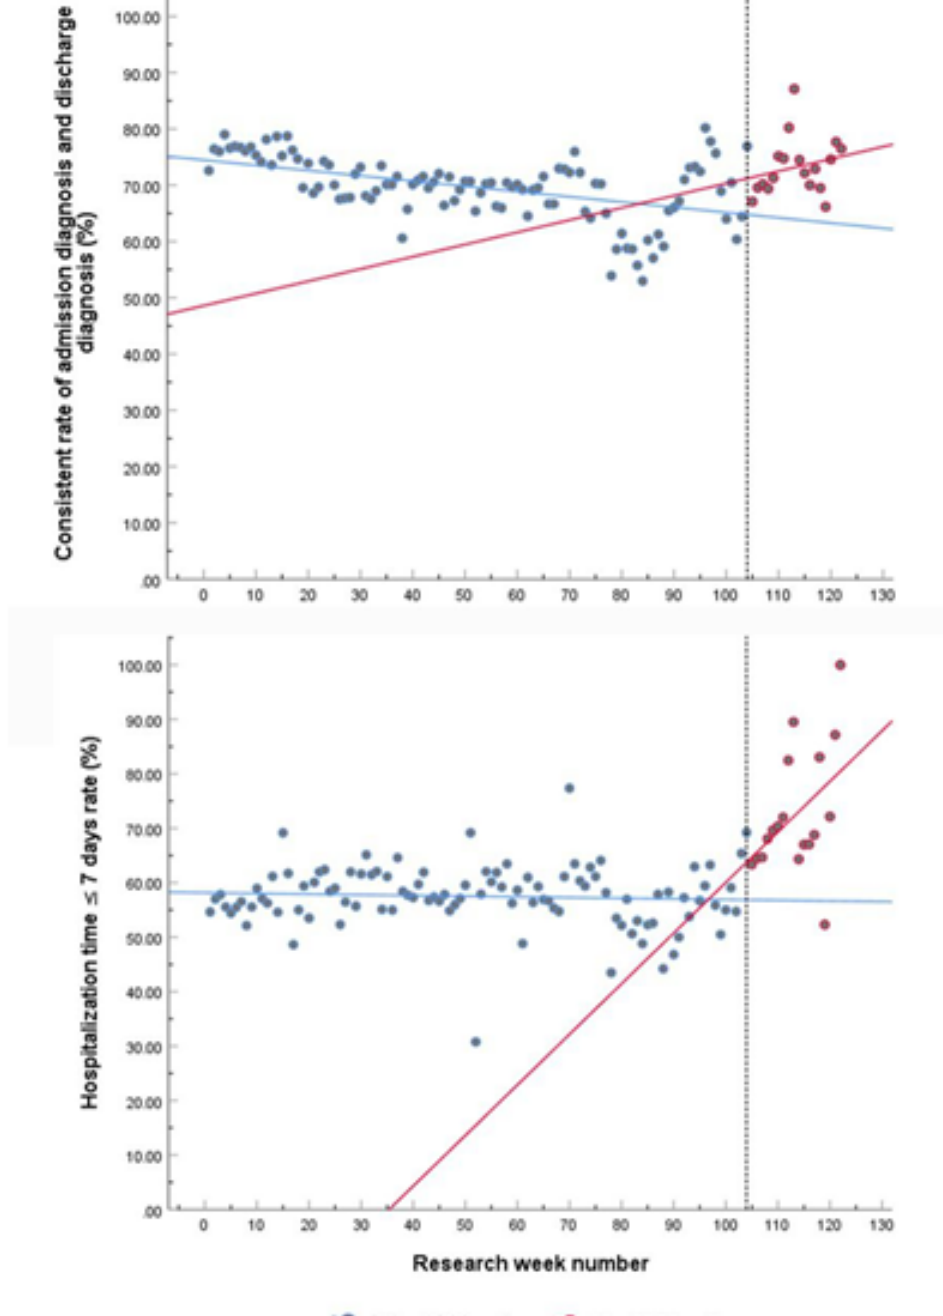
Figure 4. Levels and trend changes of the consistency of admission and discharge diagnoses and the rates of hospitalization time of 7 days or less before and after CDSS (clinical decision support systems)